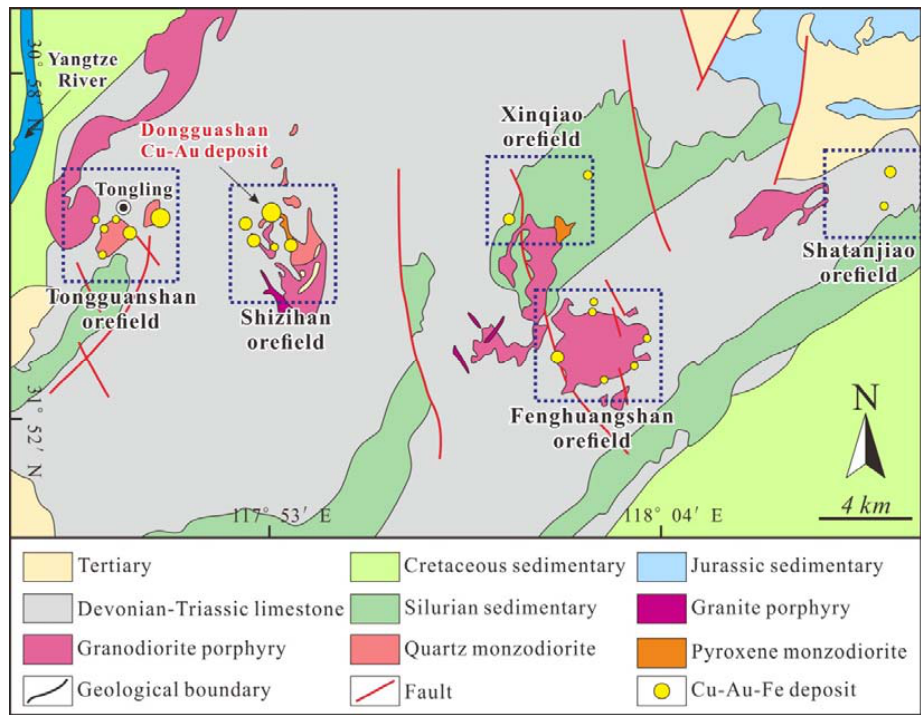
Figure 2. Geological map of the Tongling ore district [27,40].